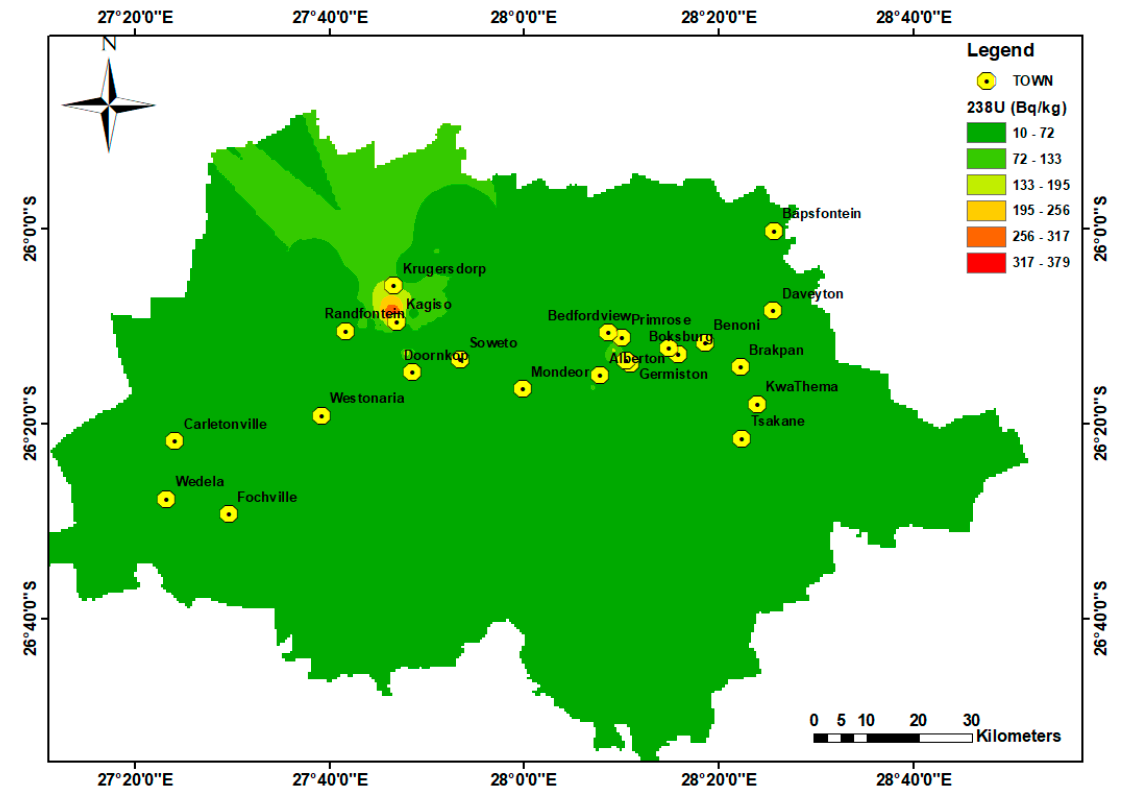
Figure 8. Spatial activity distribution map of 238 U (Bq/kg) in the surface soil.